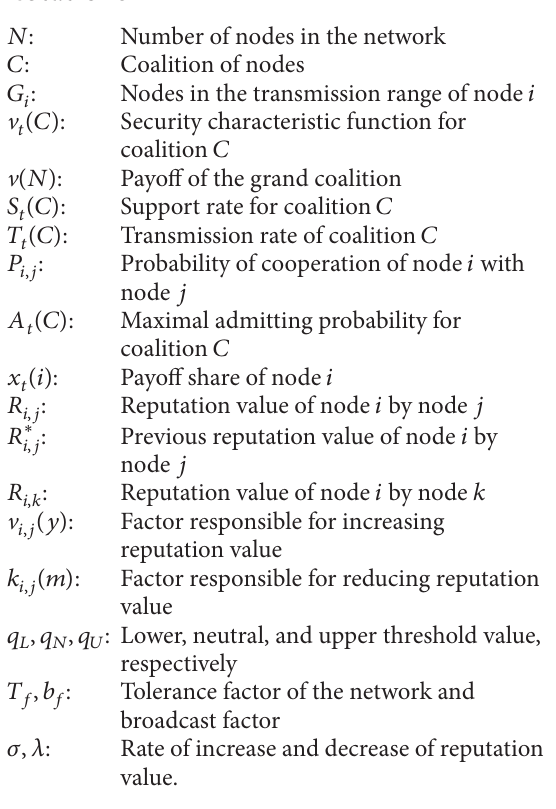
up to include thousands of nodes and this would further show that the algorithm would work best when there are so many nodes in the coalition. We would also like to investigate a case of cooperative attacks that could occur when the excluded nodes form a coalition with the aim of jamming communication in their previous